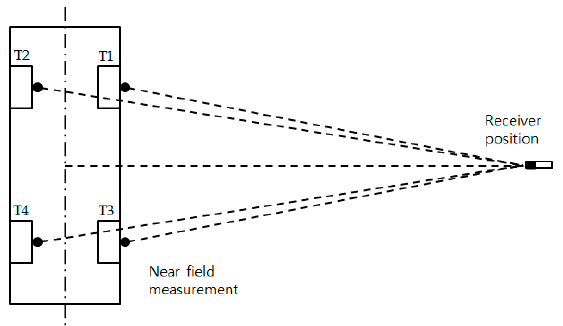
Figure 4. The physical configuration for the extrapolation of signals acquired by the proximity of the tire signals.